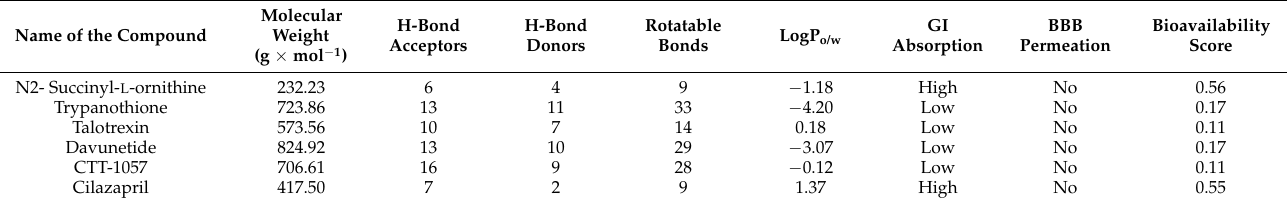
Table 5. ADME properties of top binders.